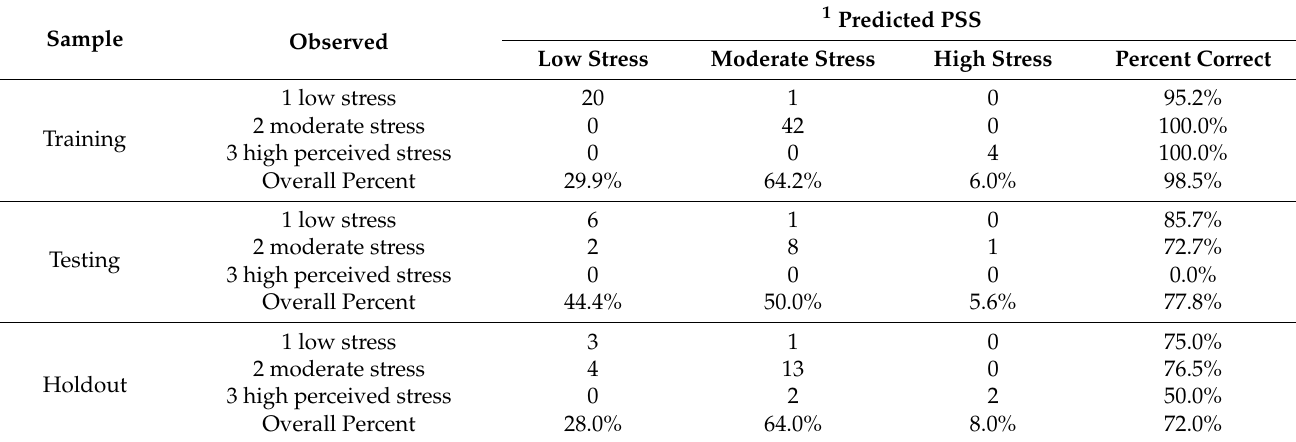
Table 6. Survey sample classification of the ANN2